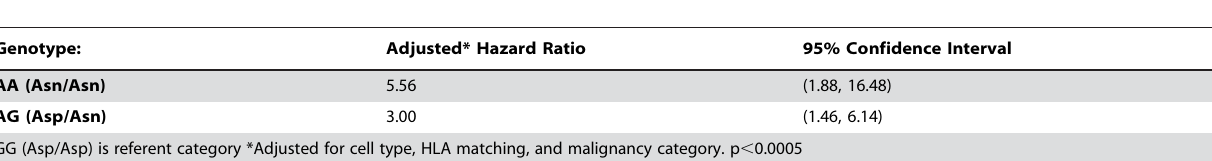
Table 2. Recipient Plg genotype is a risk factor for development of invasive aspergillosis after day 40 following HSCT.